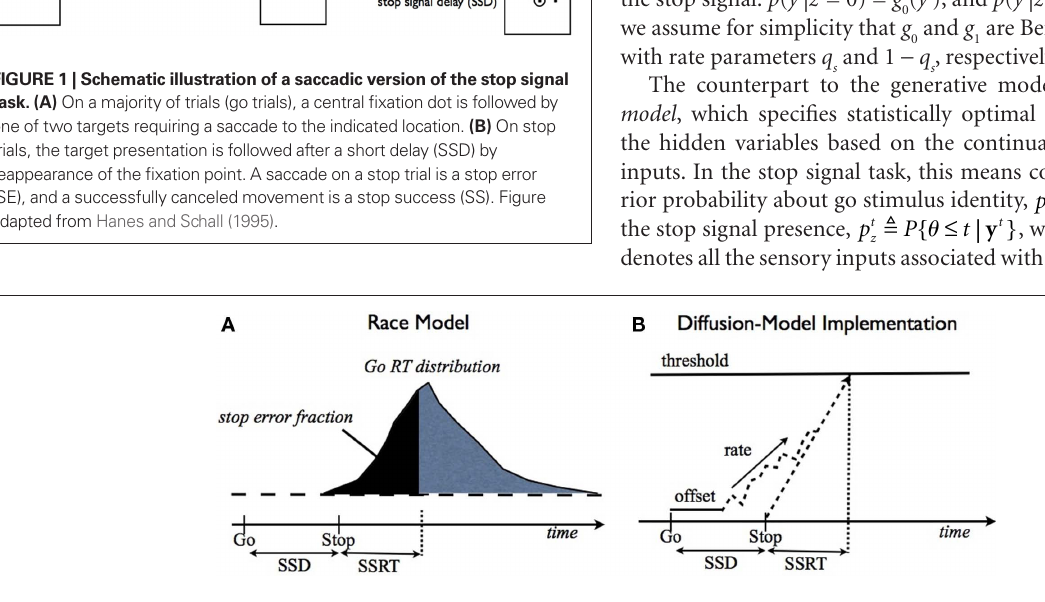
Figure 2 | race model and drift-diffusion model for the stop signal task. (A) The race model (Logan and Cowan, 1984) proposes that the finishing times of two independent (go and stop) processes determine trial outcome: stop or go, depending on which finishes first. SSD + SSRT (stop signal reaction time) specifies the finishing time of the stop process, and determines what fraction of go trials will finish earlier and therefore result in a stop error. (B) An implementation of the race model using a drift-diffusion process, similar to